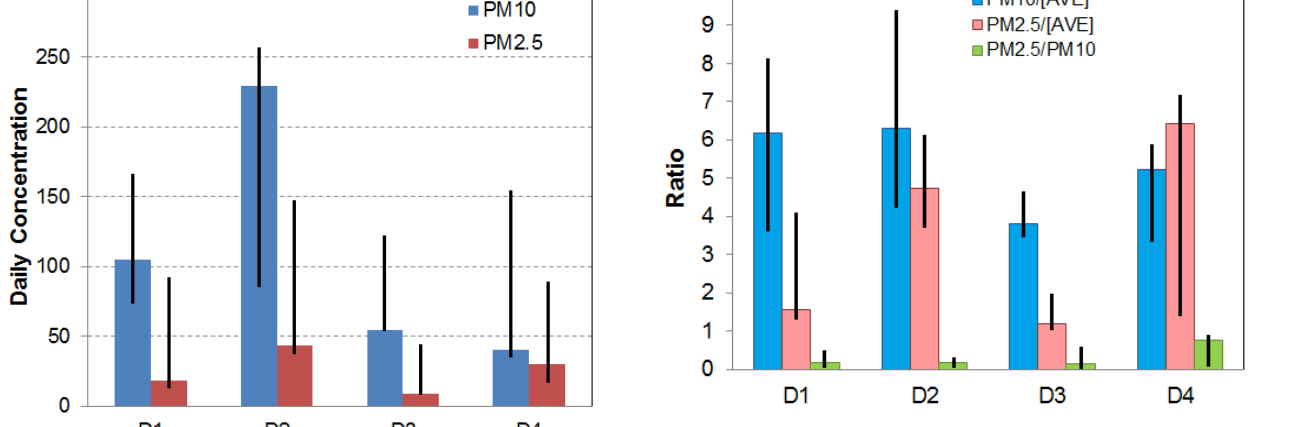
Figure 3. Ratio of PM (PM 10 and PM 2 . 5 ) concentrations on the dust storm days over the lowest 80% of PM concentrations for the month, and ratio of PM 2 . 5 concentration over PM 10 on dust storm days. Statistical ranges of ratios for each type are shown by black lines. The analysis is based on the measurements from the AQS site within the dust-storm-impacted area. D1: AQS records for event type 1 (site 480290053 for typical event); D2: AQS records for event type 2 (site PHOE1 for typical event); D3: AQS records for event type 3 (site SAGO1 for typical event); D4: AQS records for event type 4 (site WIMO1 for typical